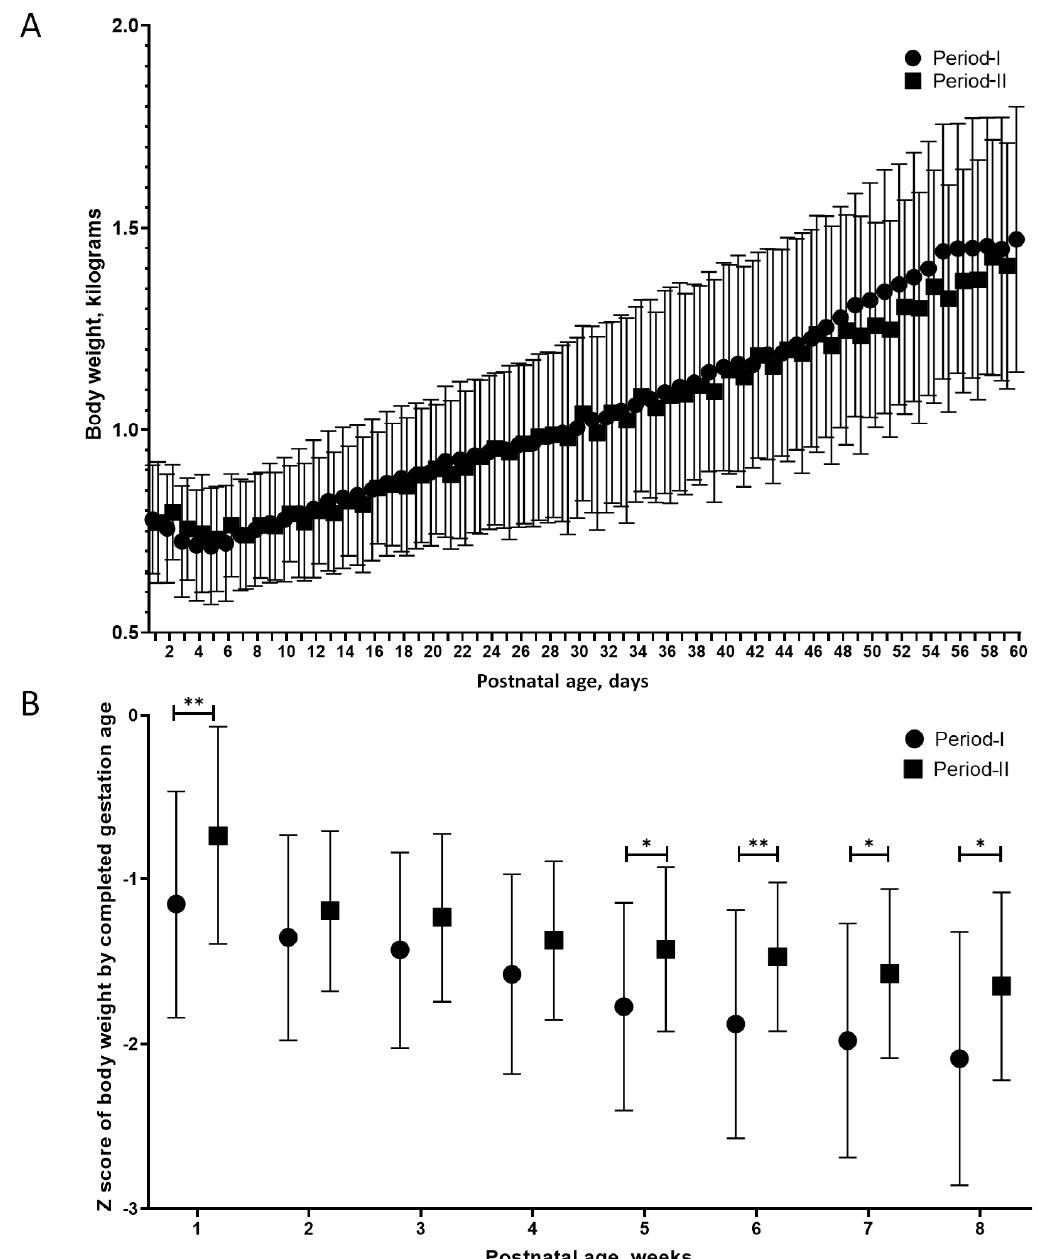
Figure 4. The differences in body weight growth dynamics in the first 2 months of life between the ELBW preterm infants in Period-I and Period-II. ( A ) The daily growth trajectory of infants in the two groups. ( B ) Weekly body weight z-scores by completed gestational age in the two groups. Data interval expressed as mean ± standard deviation. * represented as p < 0.05; ** represented as p < 0.01.